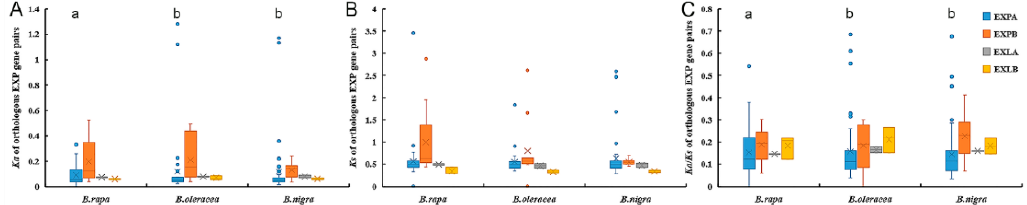
Figure 7. The Ka , Ks , Ka / Ks distributions of orthologous expansin gene pairs between A. thaliana and B. rapa , A. thaliana and B. oleracea , and A. thaliana and B. nigra. ( A – C ) Box plots of Ka , Ks , and Ka / Ks of orthologs. Vertical lines represent the range of values, boxes represent interquartile distances, and the colored line represents the median. The circles represent the abnormal values and the crosses represent the average values. Lower-case letters (a and b) indicate significant di ff erences ( p < 0.05, Tukey test). Table 3. The mean evolutionary rates ( Ka, Ks and Ka / Ks ) and promoter divergences ( d SM ) of di ff erent subfamilies’ orthologous expansin genes between A. thaliana and B. rapa , A. thaliana and B. oleracea , and A. thaliana and B. nigra .